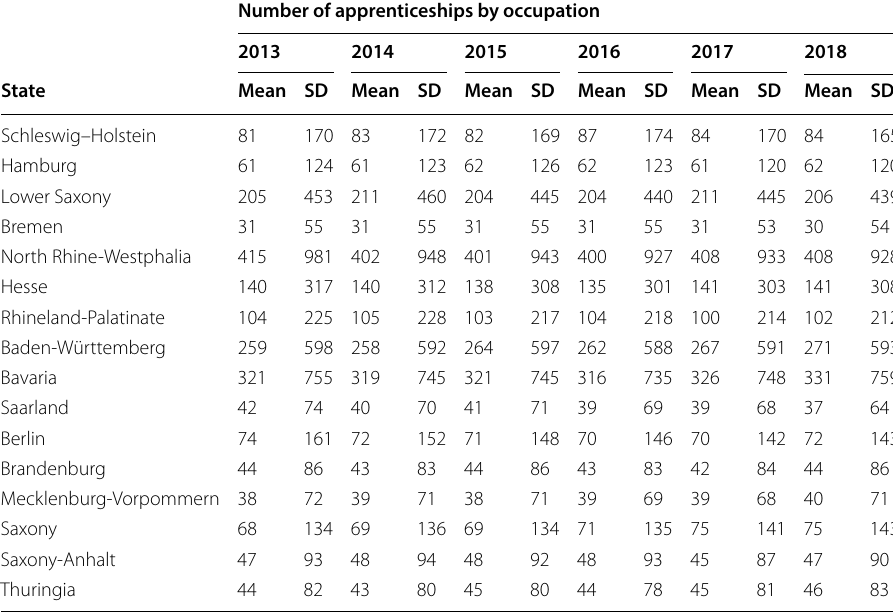
Data sources: Vocational training statistics of the statistical offices of the federal and state governments